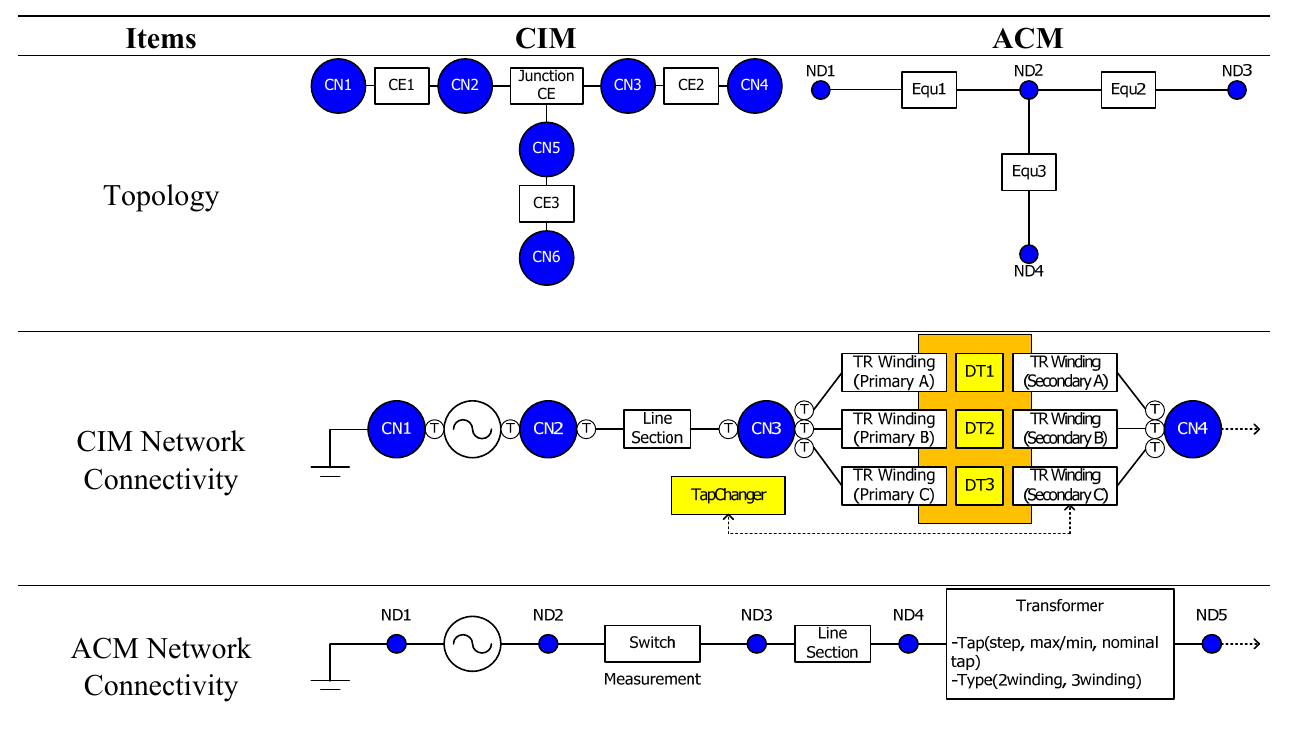
Table 1. Database modeling of